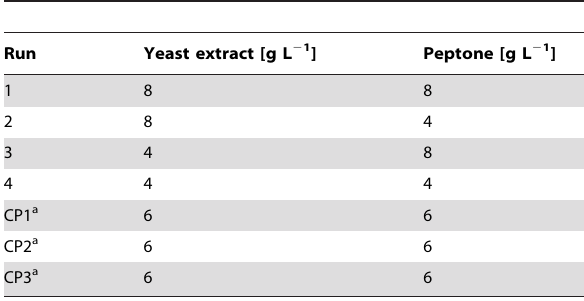
Table 2. Design matrix: Final yeast extract and peptone concentrations in